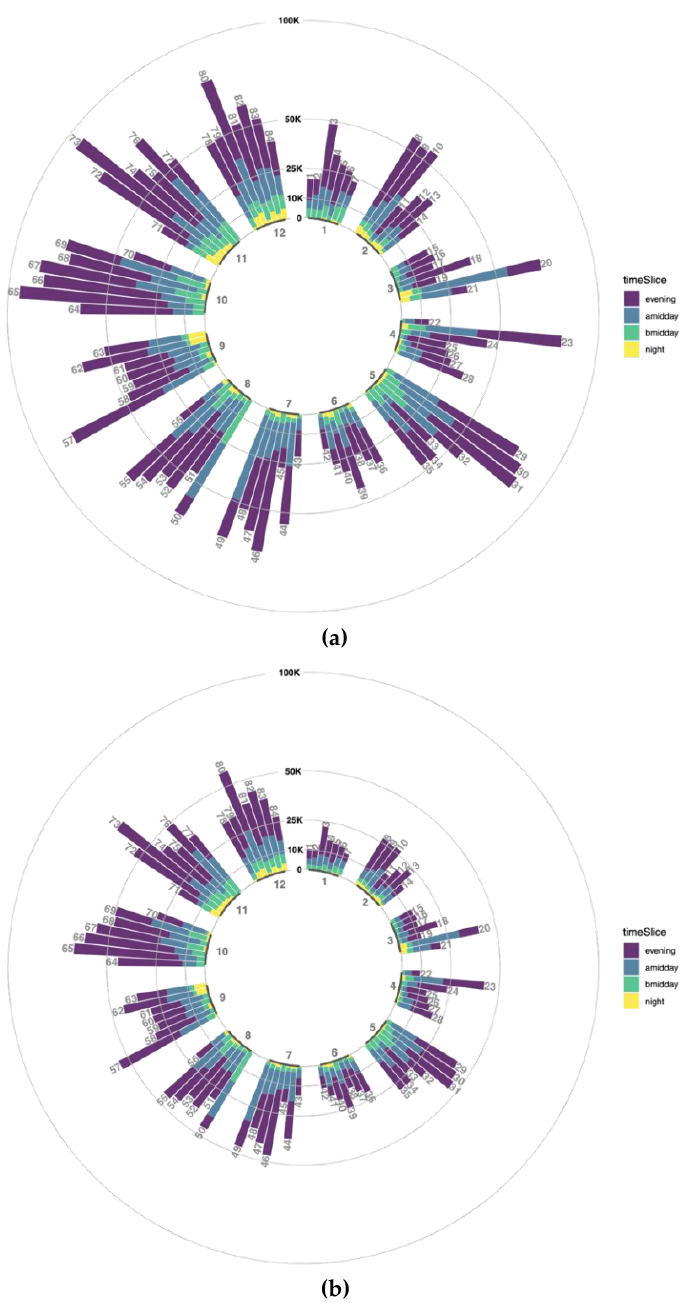
Figure 9. Circular stacked bar plots for the 2018-year data (a) number of tweets in each temporal level; (b) normalized number of tweets in each temporal level.